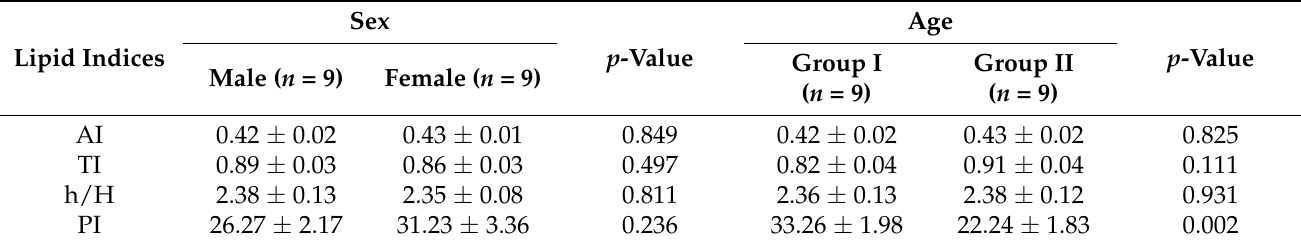
Table 4. Lipid quality indices of the brown bear, M. semimembranosus , as influenced by sex and age groups (mean ± SE).